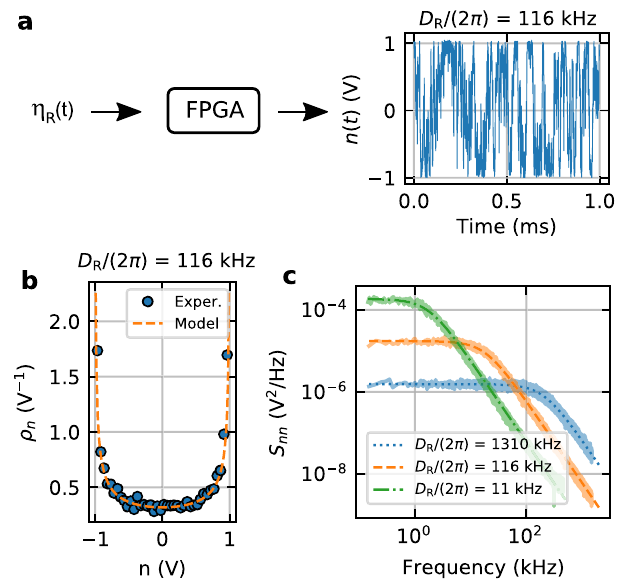
Fig. 2 Statistical properties of the active force. The values shown are electric signals which act on the particle through the Coulomb force. a Transformation of white Gaussian noise through an FPGA into the active force n ¼ A cos φ of Eqs. (1a) and (1b) ( D R = 2 π × 116 kHz). b Probability density of the realized active force in a . The arcsine distribution (dashed line) is expected from the projection onto one dimension of a constant force with fl uctuating direction. c Example spectra of active forces for three different values of D R . Panels b and c highlight the non-Markovian and non- Gaussian nature of active propulsion. We refer to Supplementary Note 6 for a derivation of the theoretical curves shown as dashed